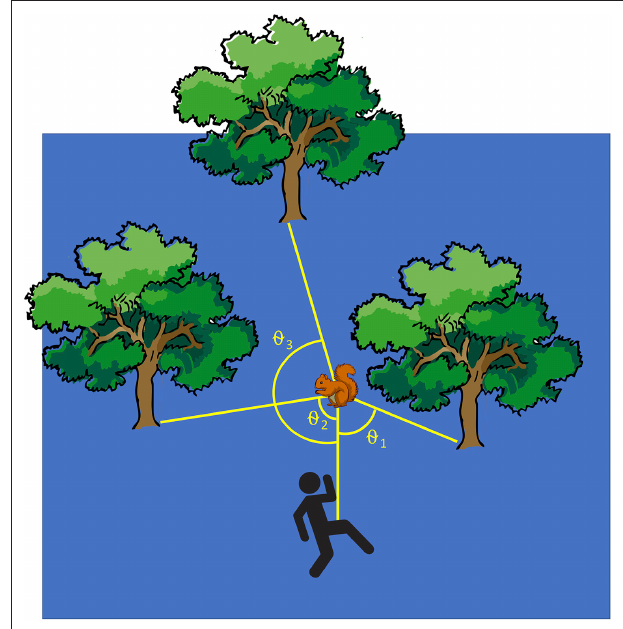
FIGURE 1 | The closest tree to the squirrel is denoted Tree 1 and the farthest is Tree 3. θ indicates the escape angle, i.e., the angle from person to squirrel to a